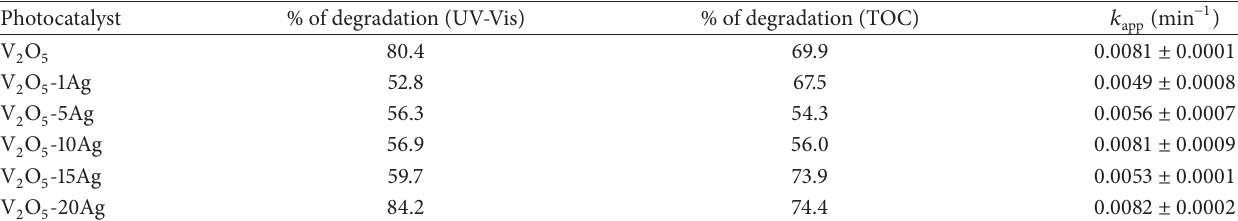
Table 4: Kinetic rateconstant ( 𝑘 app )forphotocatalytic formulationsas a function ofthesilver load, determined usinga nonlinear least squares data treatment